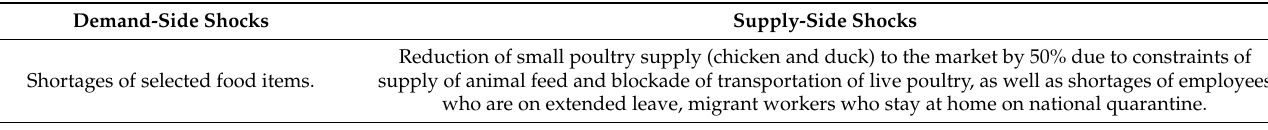
Table 4. The case of People’s Republic of China on the poultry